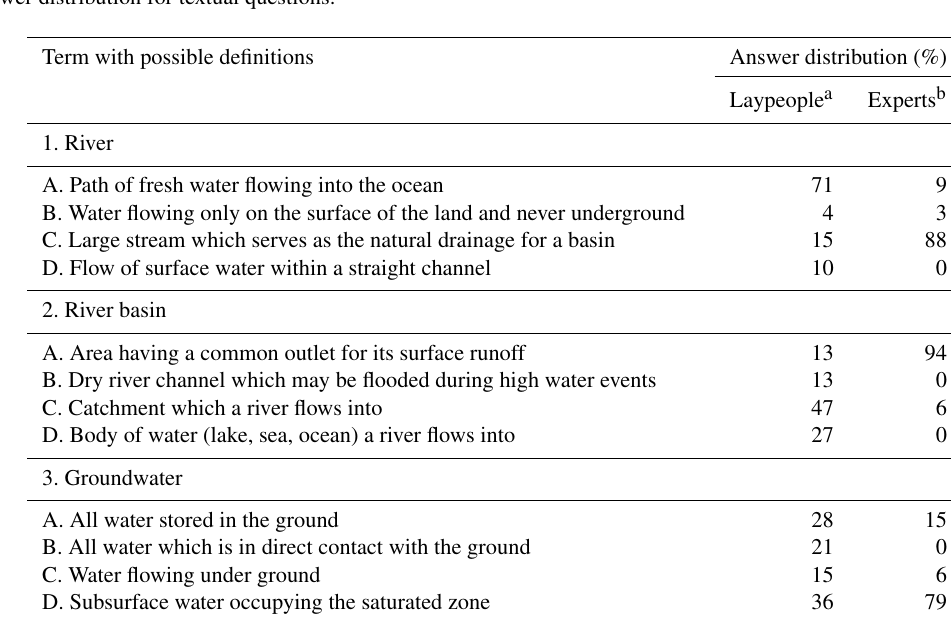
Table B1. Answer distribution for textual